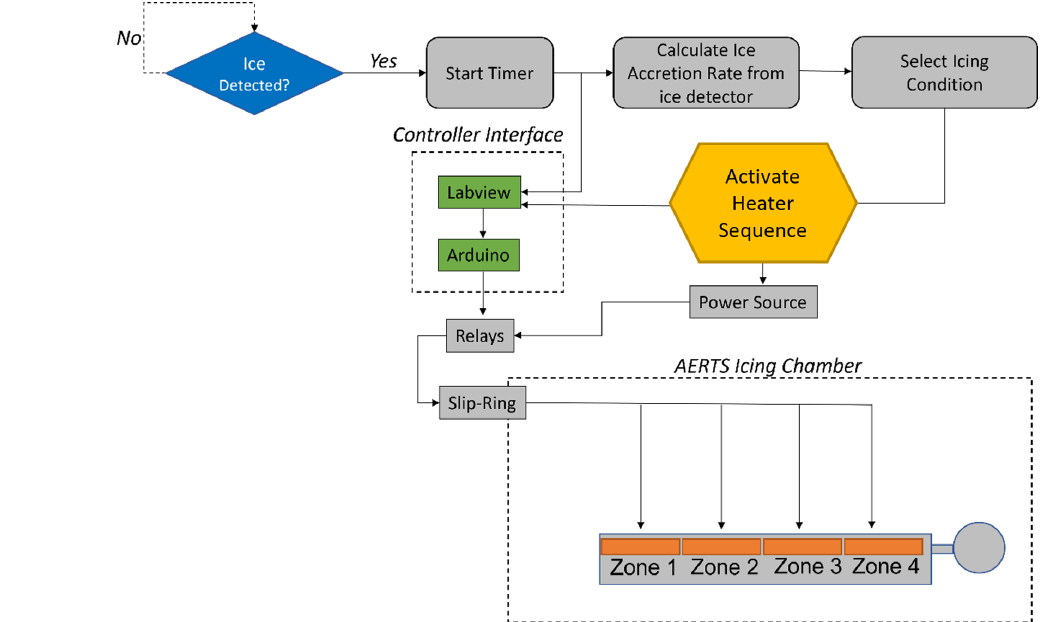
Figure 30. Flowchart of controller